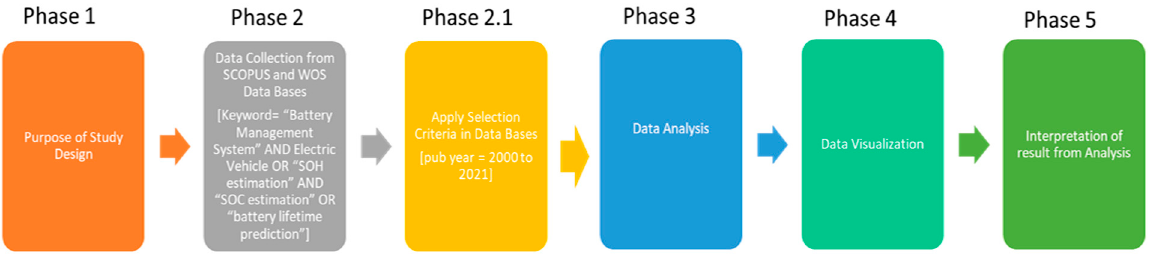
Figure 1. Methodology step by step phase process.